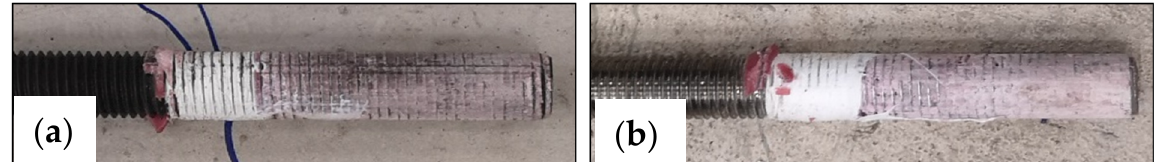
Figure 8. Typical pattern of failure in boreholes with correct preparations ( a ) and substandard cleaning ( b ), both failing with shear mortar failure at thread/mortar interface conditions in SFRC—Product B.